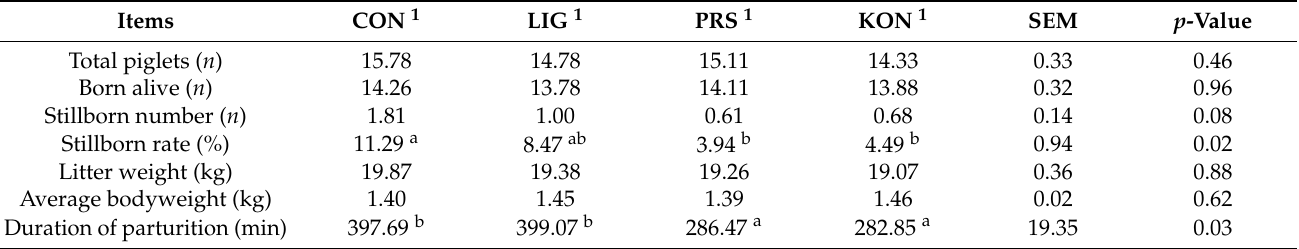
Table 2. Effects of different fiber sources on the reproductive performance and parturition duration of sows ( n =